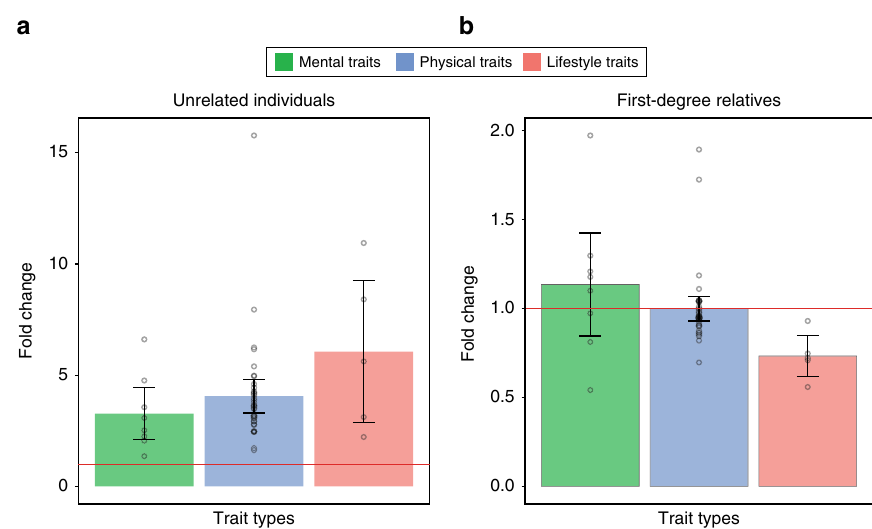
Fig. 5 The ratio between the empirical prediction accuracies in the large- and small-scale designs for three types of traits. The fi fty traits were classi fi ed into three types of traits, i.e., mental, physical and lifestyle traits, for the analyses with unrelated individuals ( a ) and fi rst-degree relatives ( b ). The main bars represent the mean values of ratios averaged over the analyses of 8, 37 and 5 traits in mental, physical and lifestyle traits, respectively. The error bars show the 95% con fi dence intervals of the mean ratios. The red horizontal line indicates a ratio of 1.